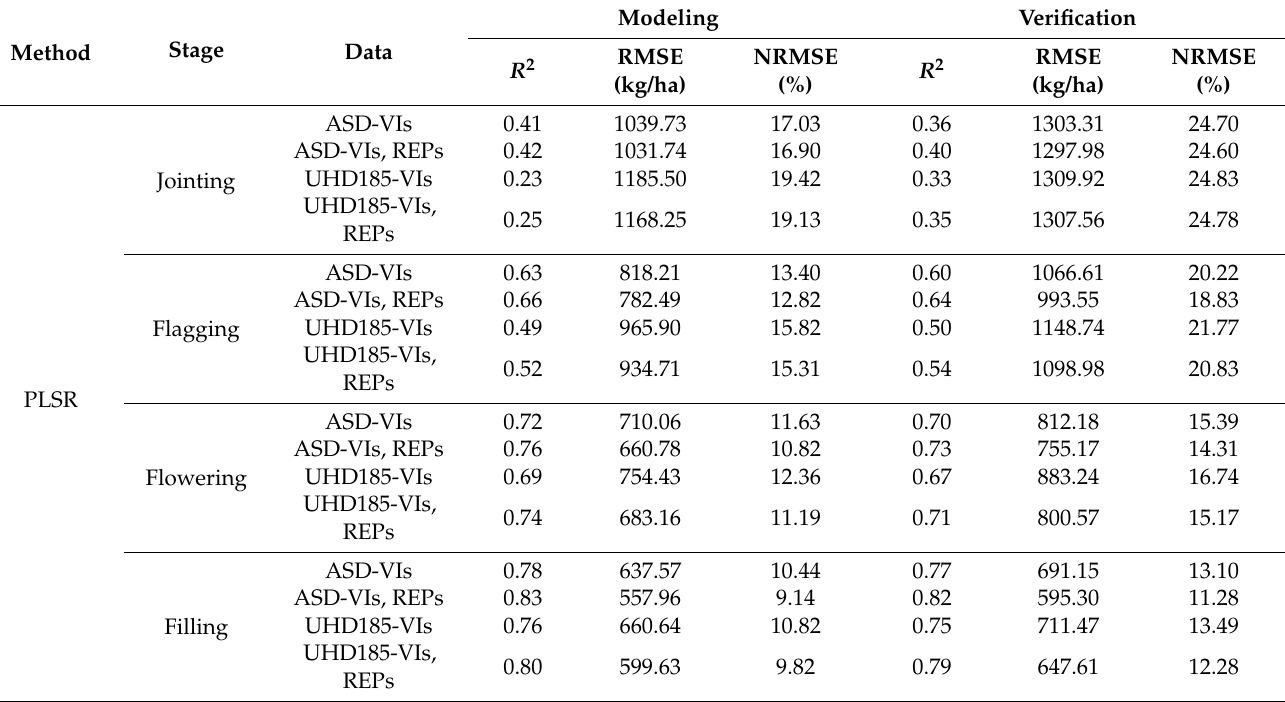
Table 6. Results of the yield estimation based on near-surface hyperspectral data and UAV hyper- spectral data using partial least squares regression (PLSR).